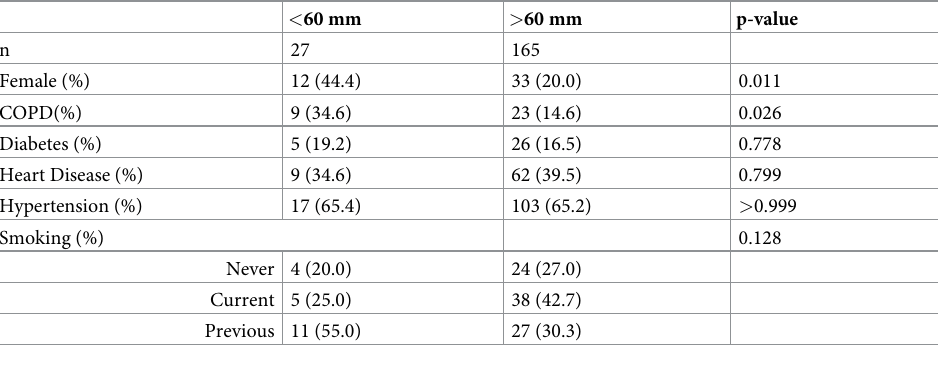
Table 3. Patient characteristics for small and large ruptured abdominal aortic